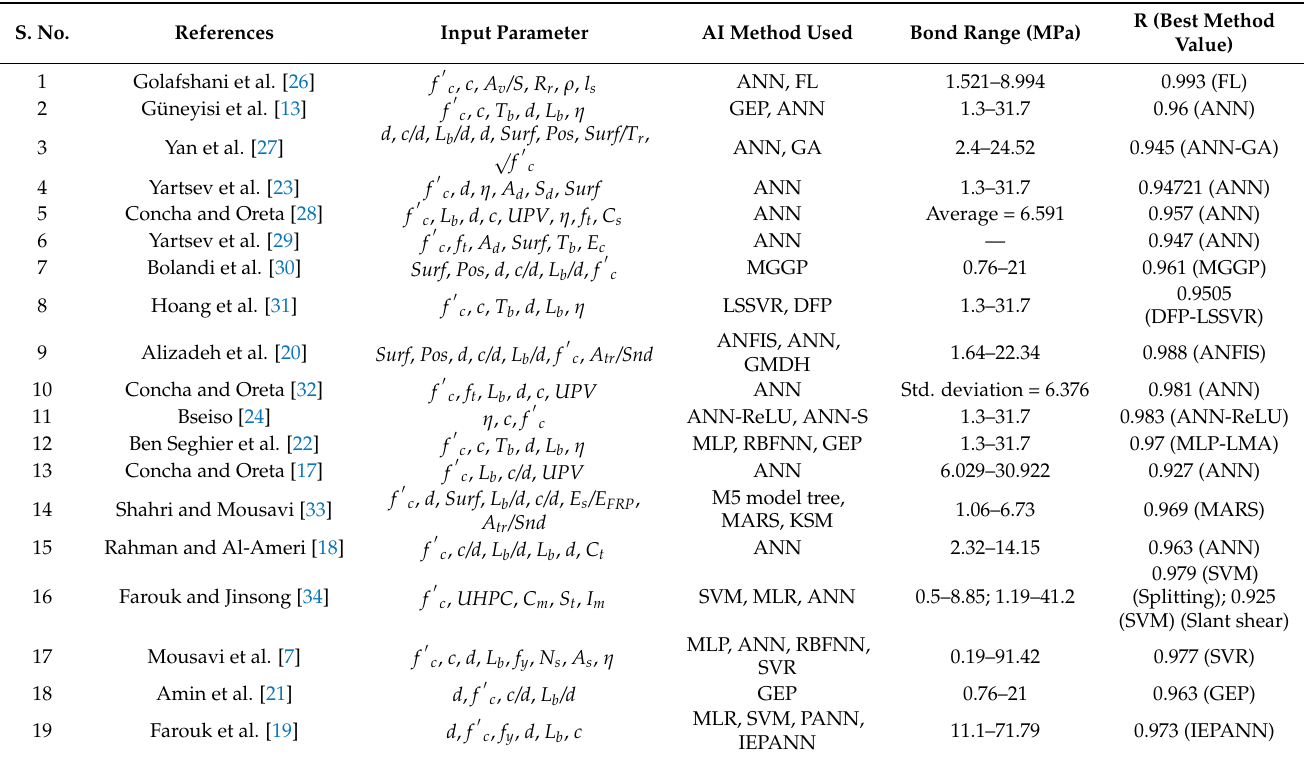
Table 1. Summary of ML models used to estimate